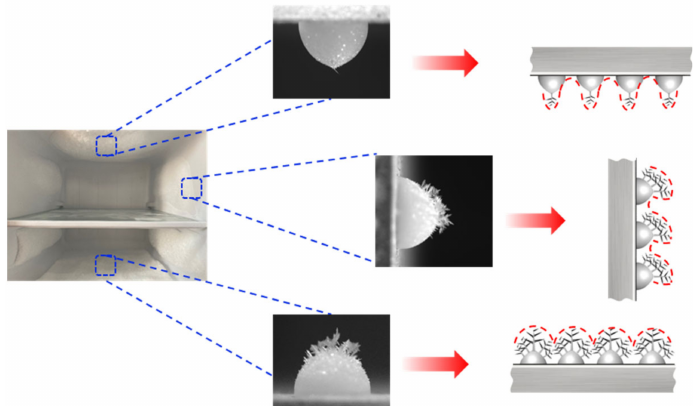
Figure 8. A practical scenario (frosting in a home freezer when leaving the chamber open for 2 h) chosen to illustrate the effect of substrate orientation on the growth of ice dendrites atop a frozen drop and the resultant profile of the frost